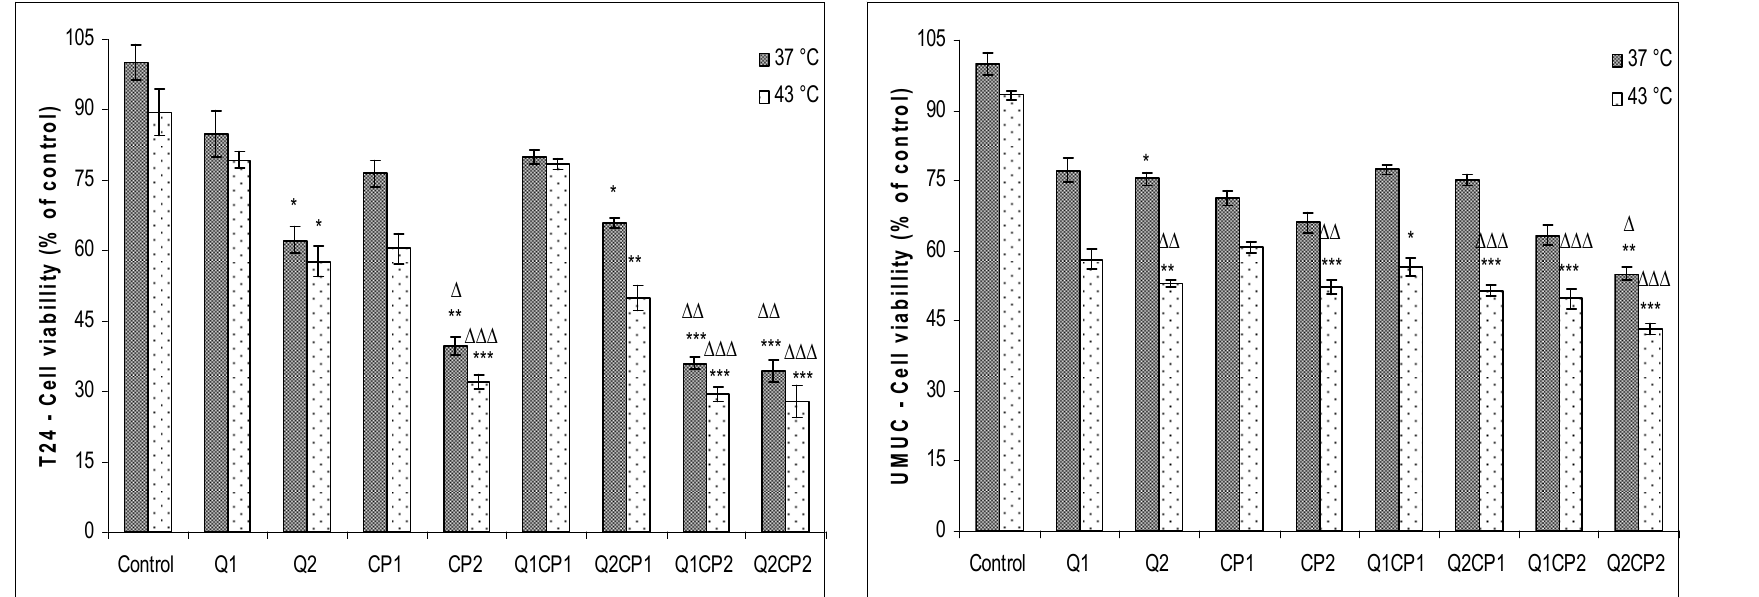
Figure 1. Effect of quercetin (QU), cisplatin (CP), and their combinations on the viability of T24 and UMUC human bladder cancer cells under physiological and hyperthermic conditions. T24 and UMUC cells were preincubated with 1 or 50 µM QU for 2 h at 37 °C, washed with phosphate-buffered saline (PBS) and incubated in fresh medium with or without 1 or 50 µM CP for 1 h under physiological and hyperthermic conditions. Cell viability was determined by 3-(4,5-dimethylthiazol2-yl)-2,5-diphenyltetrazolium bromide (MTT) assay. The data are expressed as mean ± SD of cell viability compared to control from three independently performed experiments. *Significantly different (* p < 0.05; ** p < 0.01; *** p < 0.01, nonparametric Kruskal–Wallis test) from control group 37 °C. Δ Significantly different ( Δ p < 0.05; ΔΔ p < 0.01; ΔΔΔ p < 0.01, nonparametric Kruskal–Wallis test) from control group 43 °C. Abbreviation: QU1 or QU2, treatments with quercetin at concentrations of 1 or 50 µM; CP1 or CP2, treatments with cisplatin at concentrations of 1 or 50 µM.